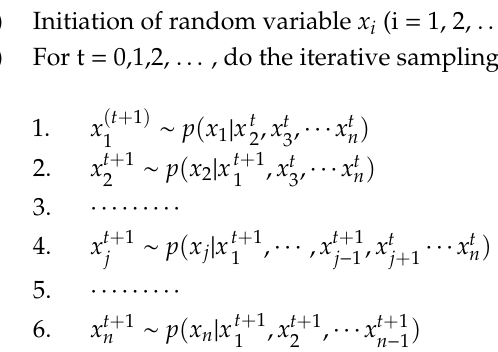
were estimated by Equation (7):